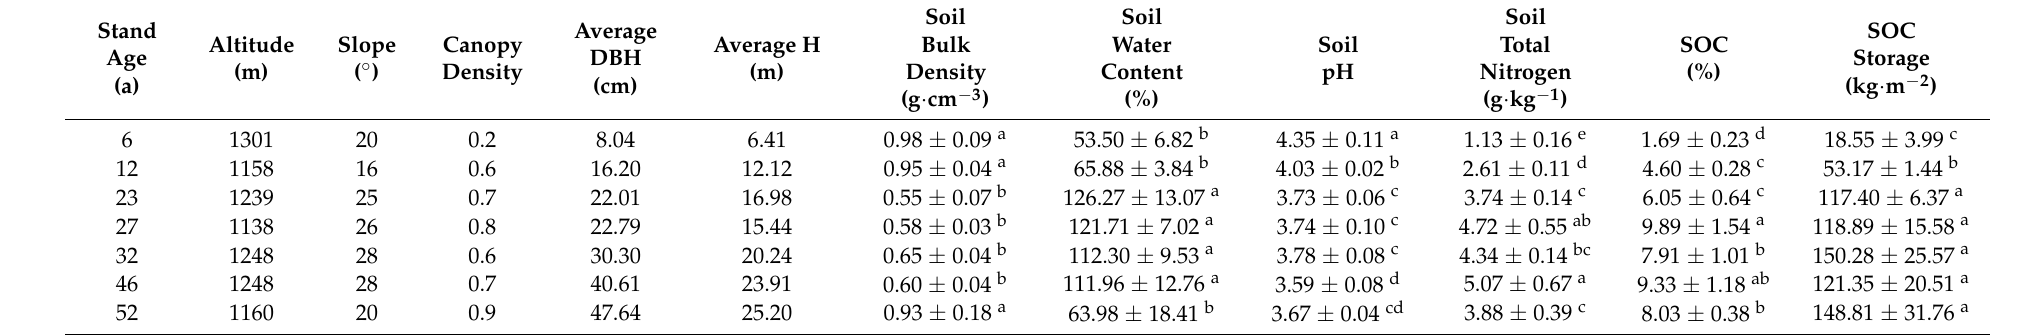
Different lowercase letters in the same column indicate significant differences between different stand ages at 0.05